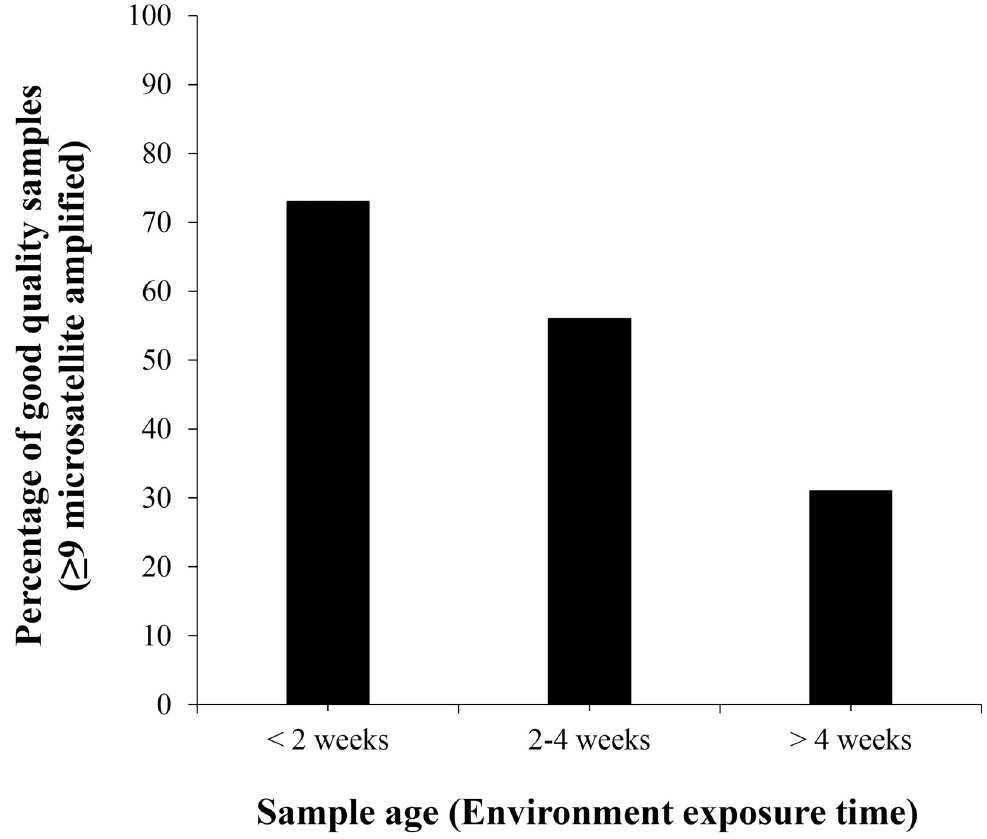
Fig 2. Relationship between sample age and genotyping success. Percentage of good quality samples in each sample age category.